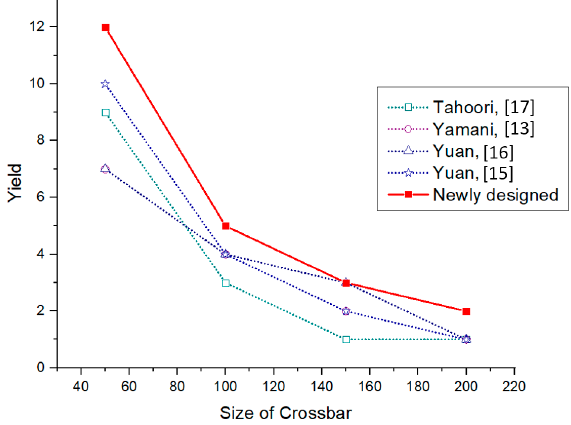
Figure 9. Yield comparison of defect-unaware fault-tolerant methods for a 15% stuck-at-off fault.